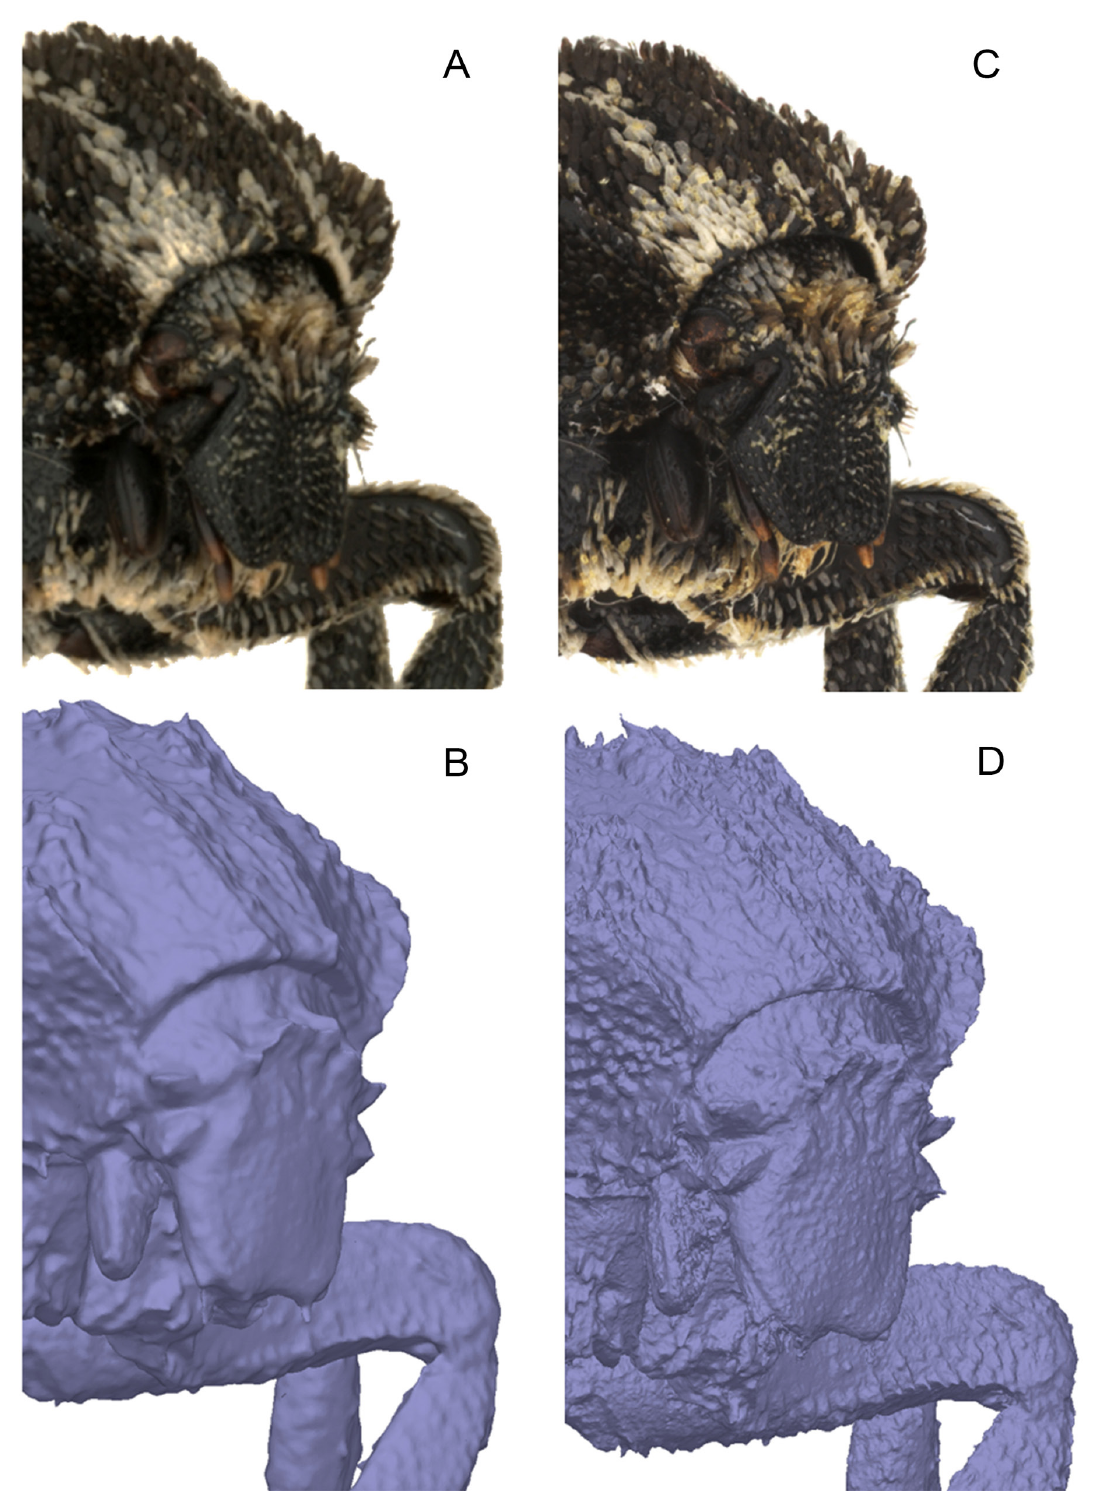
Fig. 3.16. Valgus hemipterus (7 mm body size) scanned with DISC3D at two different camera resolutions. A–B . 4 MP. C–D . 12 MP. Both images are sharp, but the 12 MP version shows more detail, resulting also in a higher spatial resolution of the model (but see Table 3.3). The textured VCM-model (low polygon- version) can be inspected at Sketchfab: